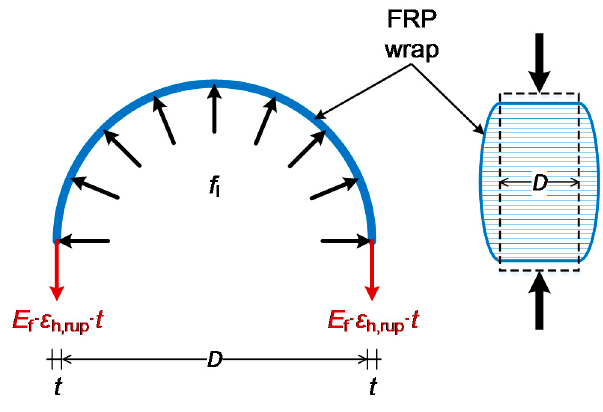
Figure 1. Mechanism of confinement in fiber-reinforced polymers (FRP)-confined concrete.